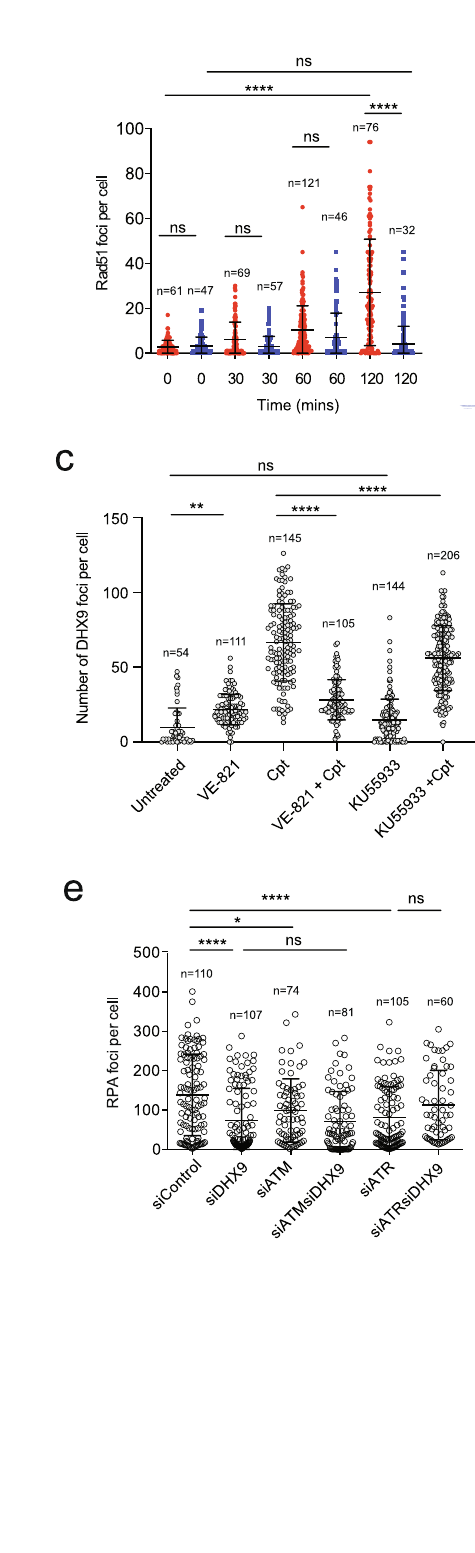
knocked down for DHX9. Signi fi cantly fewer of these cells were competent for DNA synthesis after treatment with Cpt and therefore primarily stained green. This defect was not suppressed by a loss of 53BP1. From this, we concluded that DHX9 plays an important role in the restart of DNA synthesis in response to Cpt-induced DNA damage. We hypothesize that DHX9, along